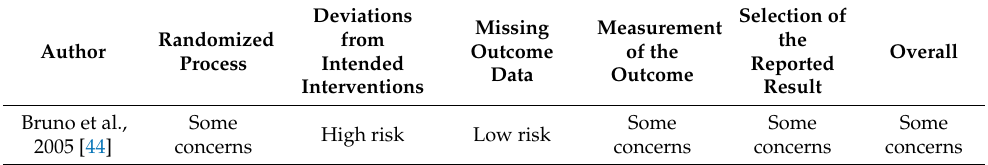
Table 5. Risk of bias of randomized controlled trials according to the Cochrane Risk of Bias Tool